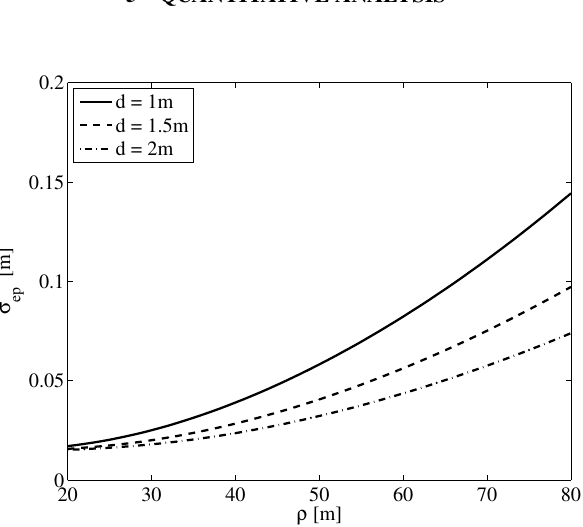
Figure 5: Terrestrial target horizontal position standard deviation versus MAV flight altitude ρ and target size d assuming the flight speed of v = 5 m/s and synchronization error of τ = 1 ms.